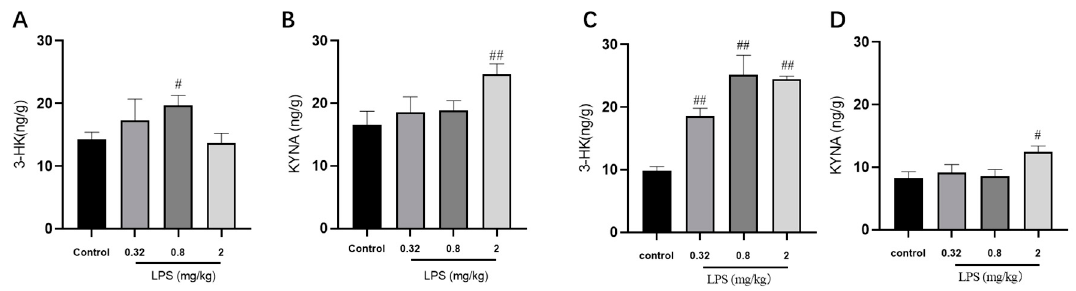
Figure 3. Effects of different doses of LPS (i.p.) on the levels of metabolites of the KYN pathway in the brain of mice. The contents of 3-HK and KYNA in the hippocampus ( A , B ) and cortex ( C , D ). Graphs are plotted as mean ± SEM ( n = 7 for each group). Data were analyzed by one-way ANOVA followed by LSD test. # p < 0.05, ## p < 0.01 compared to the control group.